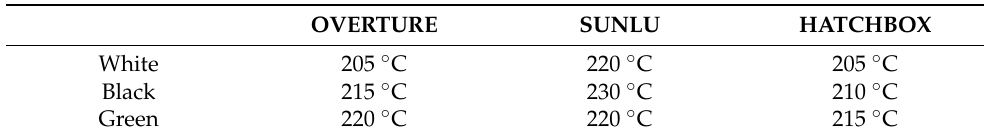
Table 1. Optimal nozzle temperatures for each brand–color combination qualitatively determined using temperature towers.